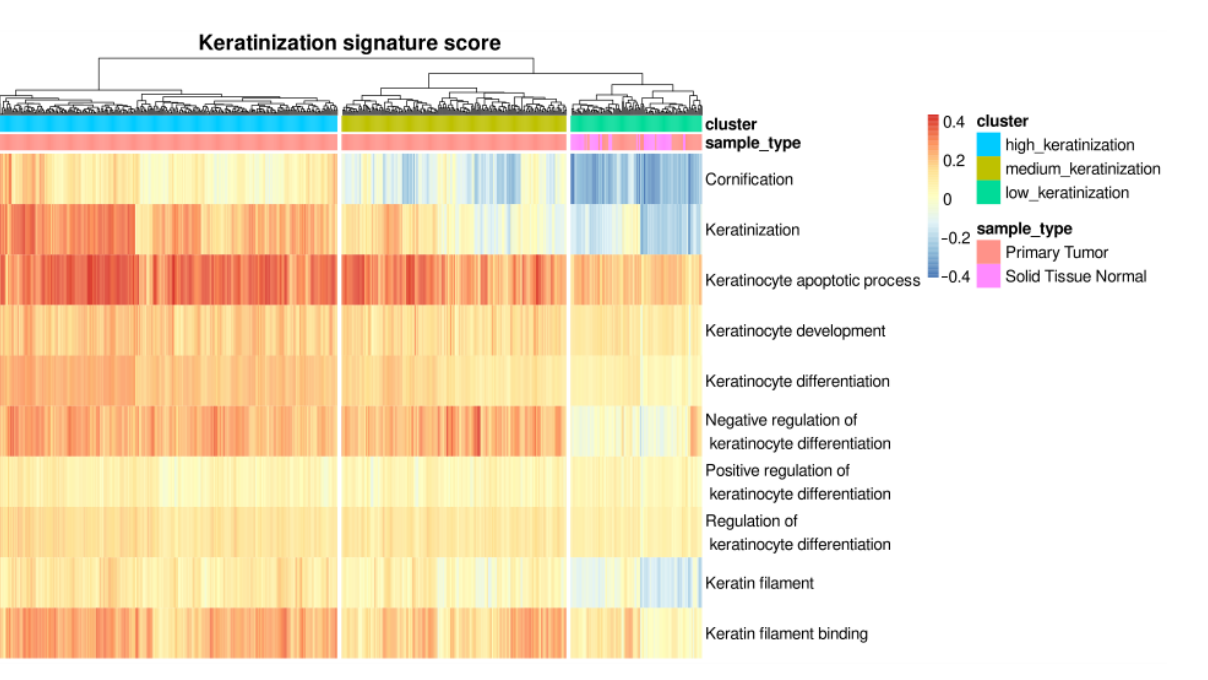
Figure 2. The classification of the LUSC samples into three groups, low keratinization, medium keratinization, and high keratinization, based on the keratinization-related GO gene sets. Each column represents a sample. Each row represents a keratinization molecular signature from Gene Ontology. The heatmap units are the Singscore value. Positive Singscore values represent enrichment of the gene set. In contrast, negative values represent underrepresentation of the gene sets. Table 2. The top identified regulatory factors that influence keratinization process in